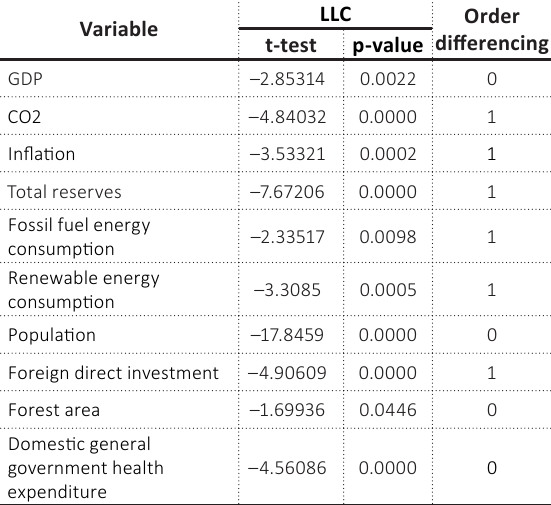
Table 3. Panel unit root test results for research